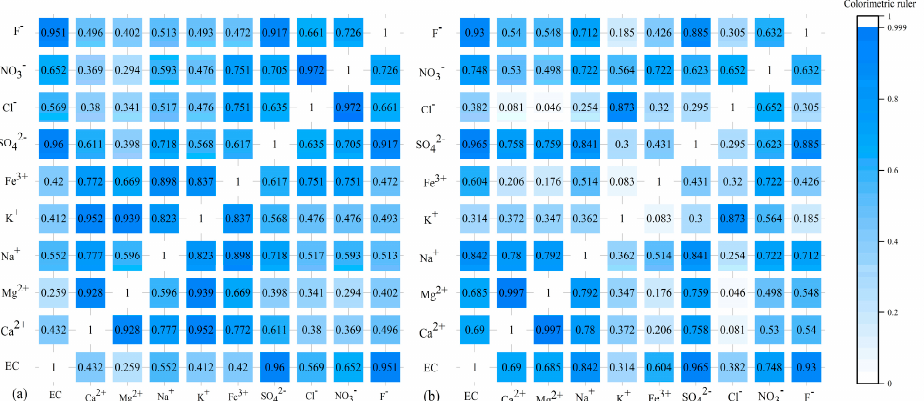
Figure 9. EC and ions correlation plots of FGK1 and FGLU immersion solution. ( a ) EC and ion correlation heat map of FGU immersion solution; ( b ) EC and ion correlation heat map of FGLU immersion solution)